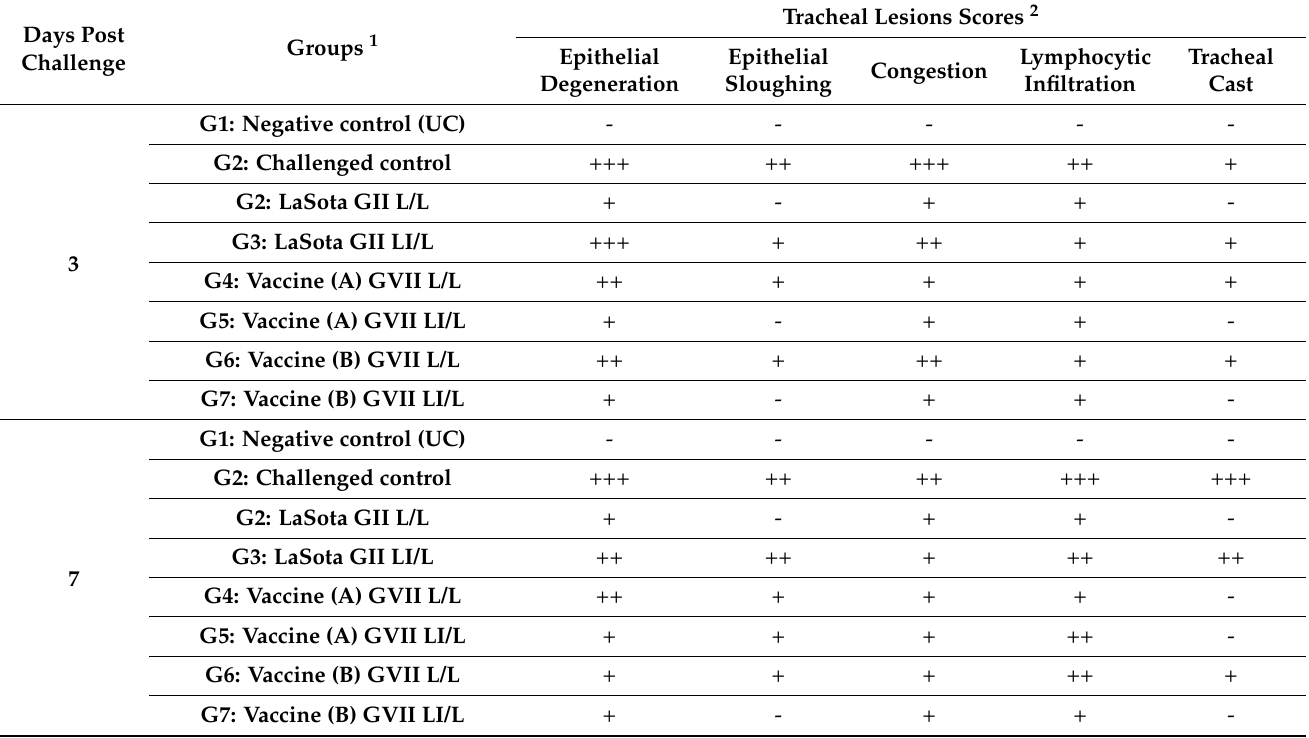
Table 5. The histopathological scoring of tracheal lesions at 3 and 7 days post